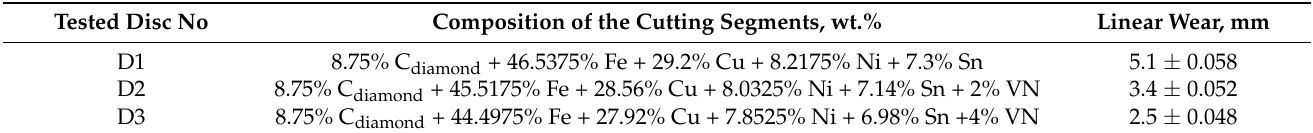
Table 5. Results of initial cutting tests.